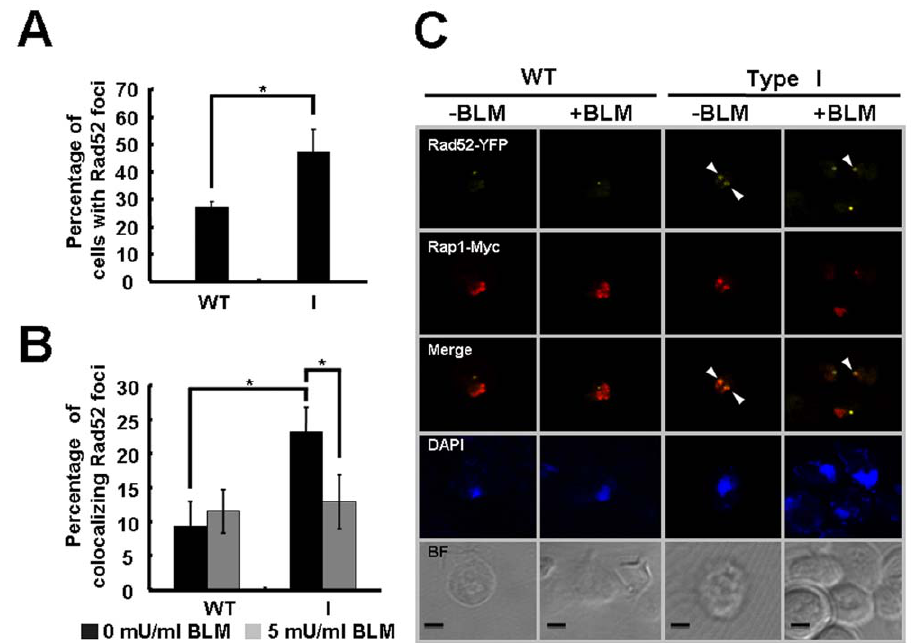
Figure 6. Localization of Rad52 to telomeres in cells with short telomeres. ( A ) The percentage of cells forming spontaneous Rad52-YFP foci was scored as described in Materials and Methods. ( B ) The percentage of Rad52-YFP foci colocalized with Rap1-Myc. Wild-type and type I cells expressing Rad52-YFP and Myc-tagged Rap1 were arrested in G1 with a -factor for 2.5 hours. Half of the culture was exposed to bleomycin for 30 min to generate DSBs. Cell treated with or without bleomycin were released into S-phase for 90 min. Before the addition of belomycin, the proportion of colocalized Rad52 in type I cells differed from that in wild-type in a statistically significant manner ( P values =0.019), and in type I cells, the percentage of colocalization prior to bleomycin treatment (black bars) also differed from that after treatment (gray bars) in a statistically significant manner ( P values =0.0232). Error bars represent standard deviations for at least three independent experiments. ( C ) Images of representative cells from the experiment in panel B show colocalization of Rad52 and Rap1 in type I cells. Scale bar, 2 m m. Arrowheads mark selected foci. BF, bright field.